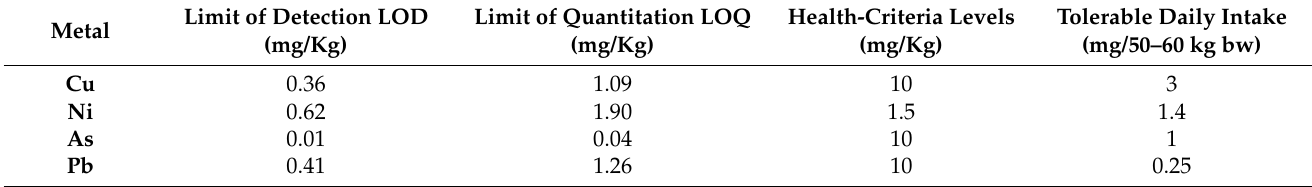
Table 4. LOD, LOQ, tolerable daily intake and World Health Organization permissible limit of Ni, Cu, As, and Pb in the medicinal